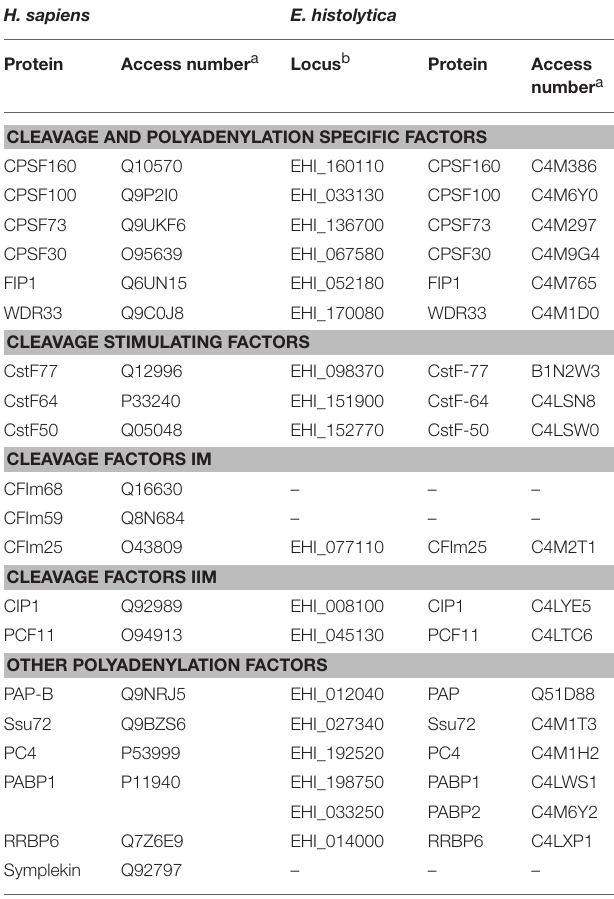
TABLE 2 | Polyadenylation factors in human and E. histolytica